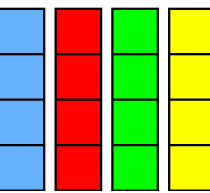
Figure 13. A grid of 4 × 4 cells partitioned into vertical strips of four cells each.